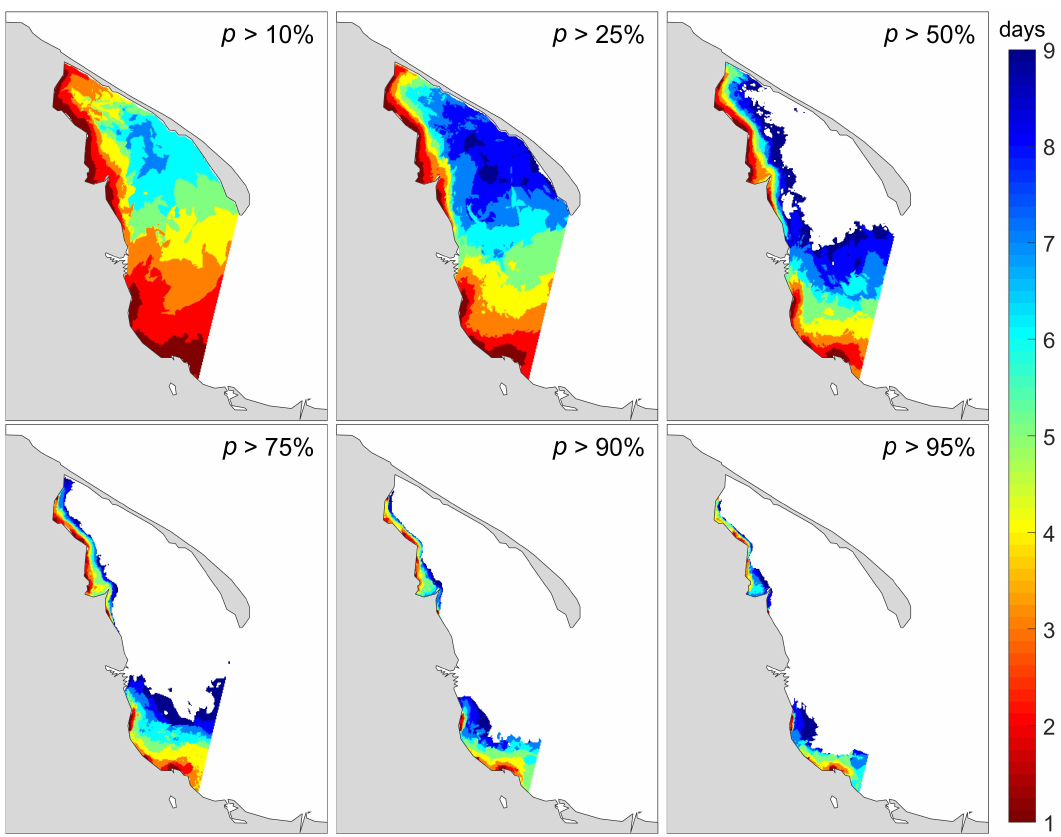
Figure 13. The number of days it takes for pollutants to occur at a location with a probability of more than p > { 10%,25%,50%,75%,90%, and 95% }